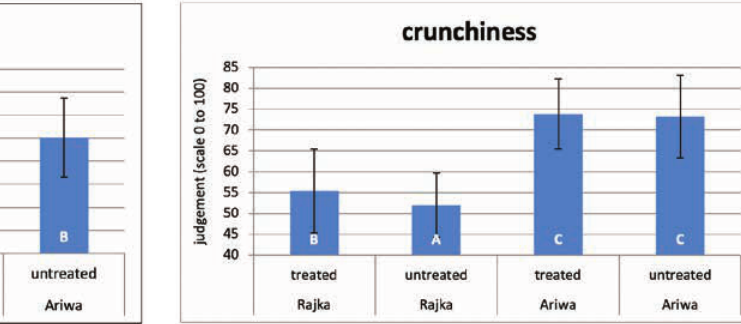
= 320, n = 80, means appels persons